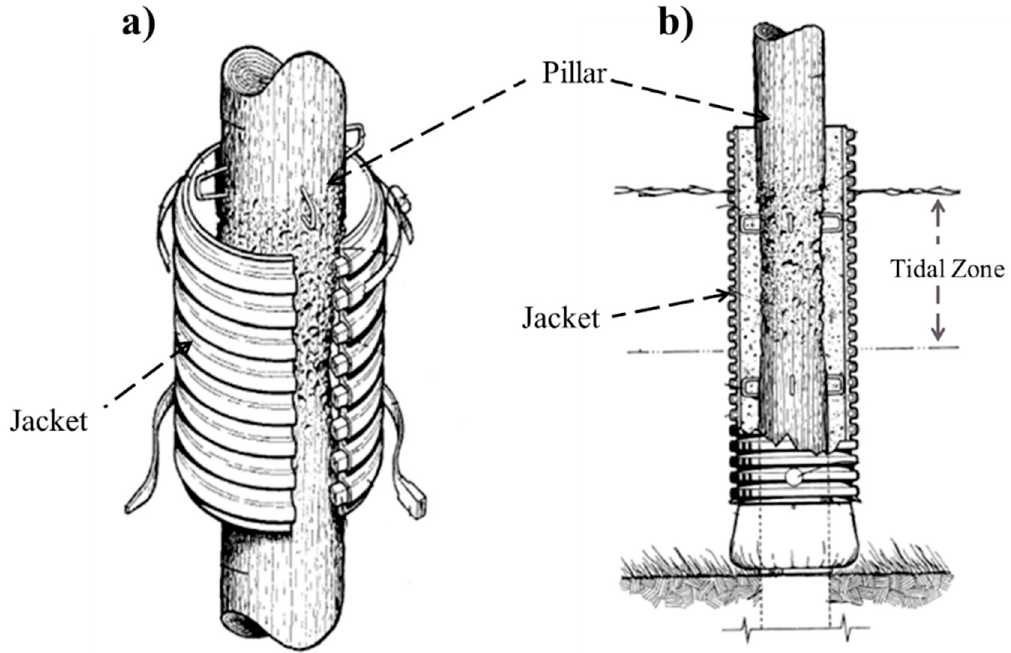
Figure 7. ( a ) scheme of pillar repair jacket, ( b ) example of installation of the jacket within the tidal zone [54].